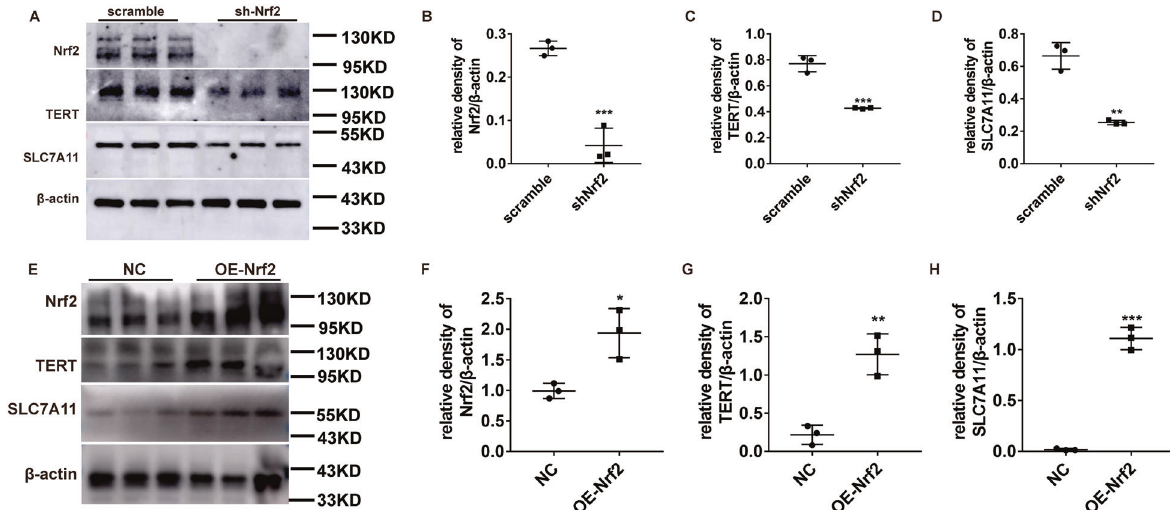
Fig. 5 Nrf2 positively regulates TERT and SLC7A11 levels during OGD/R-driven ferroptosis in pulmonary epithelial cells. A , E Evaluation of Nrf2 and its potential downstream signaling proteins via western blotting, under different conditions. B – D , F – H Quanti fi cation of the examined proteins. Error bars denote standard error from three individual experiments. Data are expressed as mean ± SEM. * P < 0.05, ** P < 0.01, *** P < 0.001 represent intergroup signi fi cant